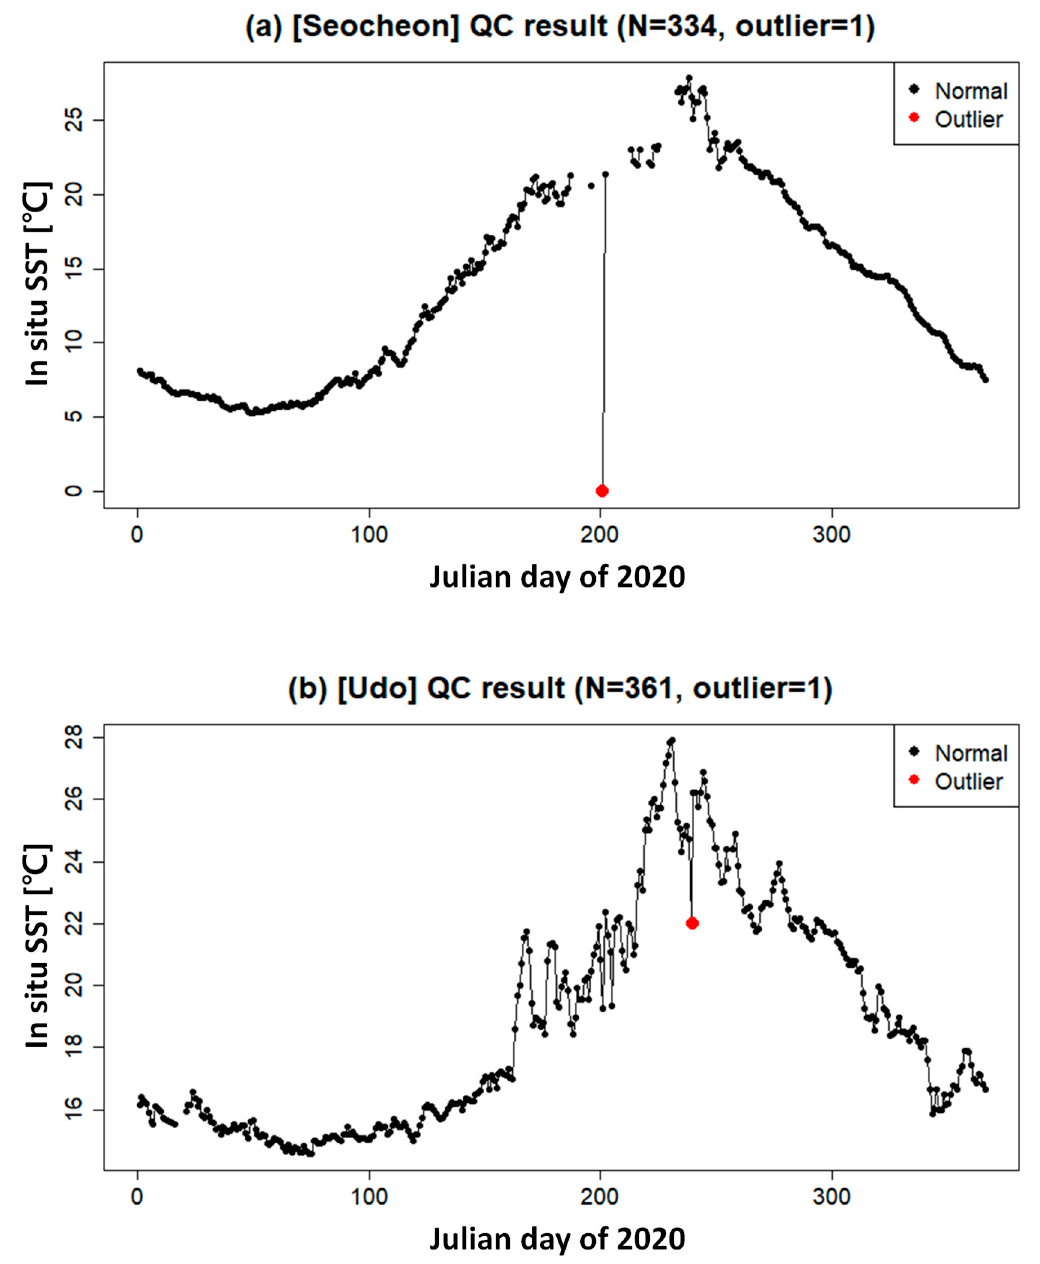
Figure 4. Example of quality control results for in situ SST observations at ( a ) Seocheon and ( b ) Udo. The black point denotes the normal data of the time series, and the red point is the outlier detected by the quality control process.